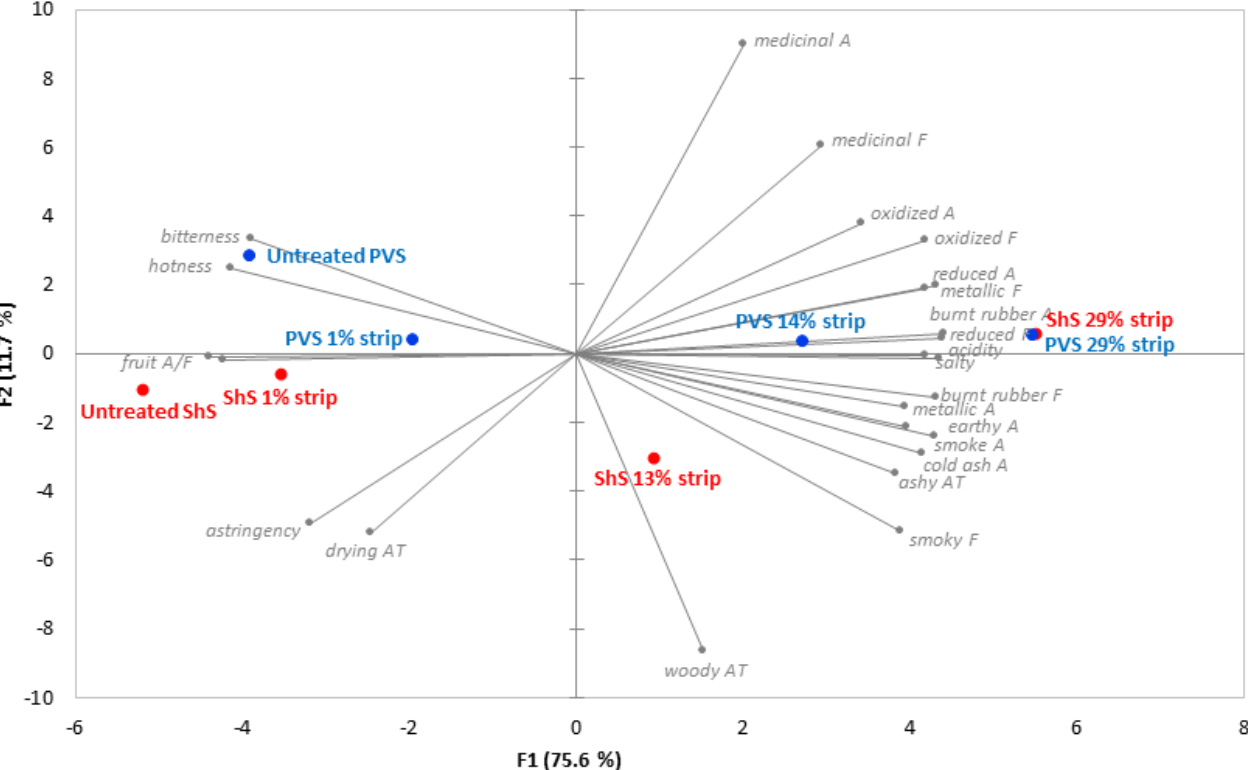
Figure 2. Principal component analysis biplot of mean sensory attribute ratings for smoke-tainted Shiraz Sangiovese (ShS) and Petit Verdot Sangiovese (PVS) wines, before and after spinning cone column distillation. A = aroma, F = flavor, AT = aftertaste.